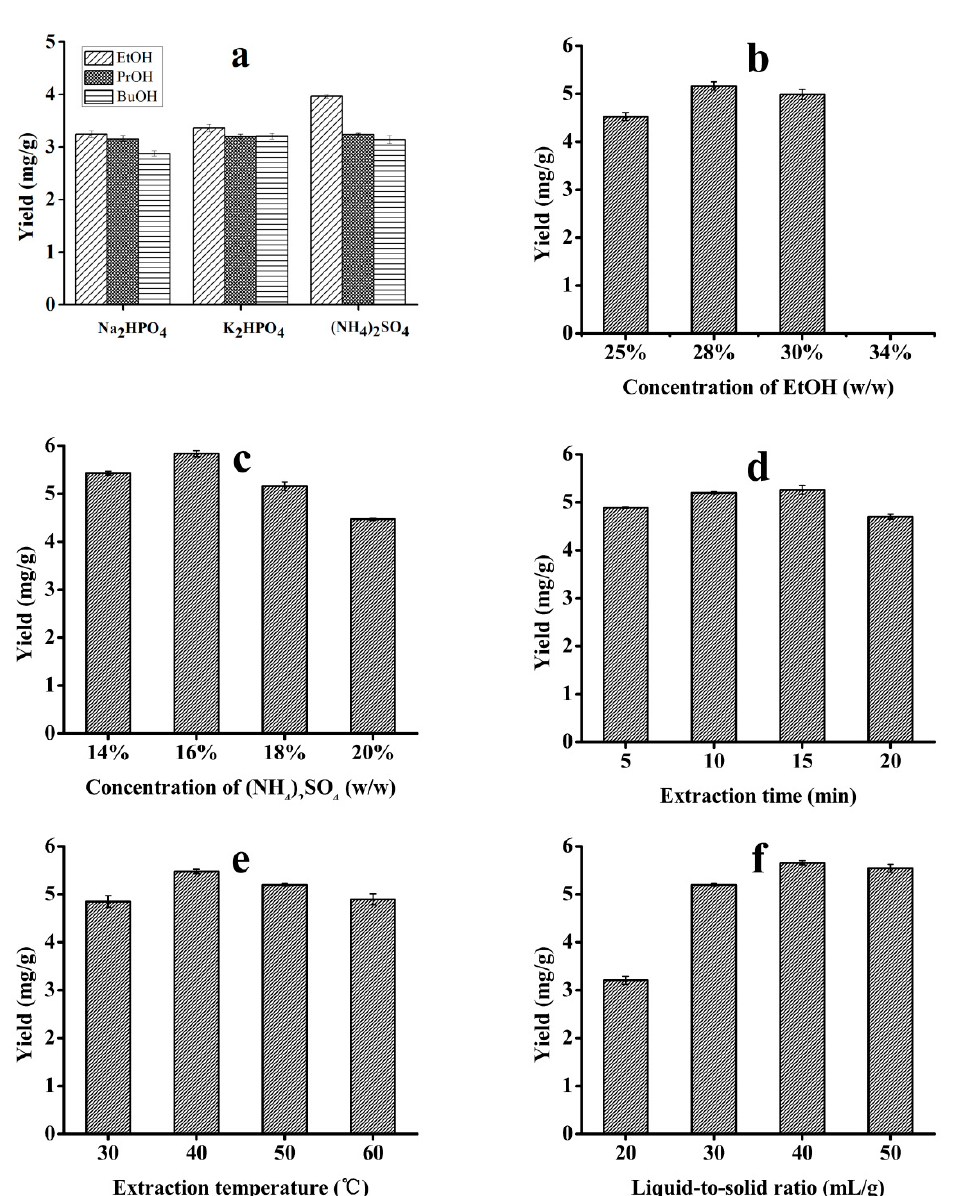
Figure 2. Different parameters of ( a ) type of aqueous two-phase system (ATPS), ( b ) EtOH concentration, ( c ) (NH 4 ) 2 SO 4 concentration, ( d ) ultrasonication time, ( e ) extraction temperature, and ( f ) liquid-to-solid ratio for the extraction of solasodine using MAATPE.